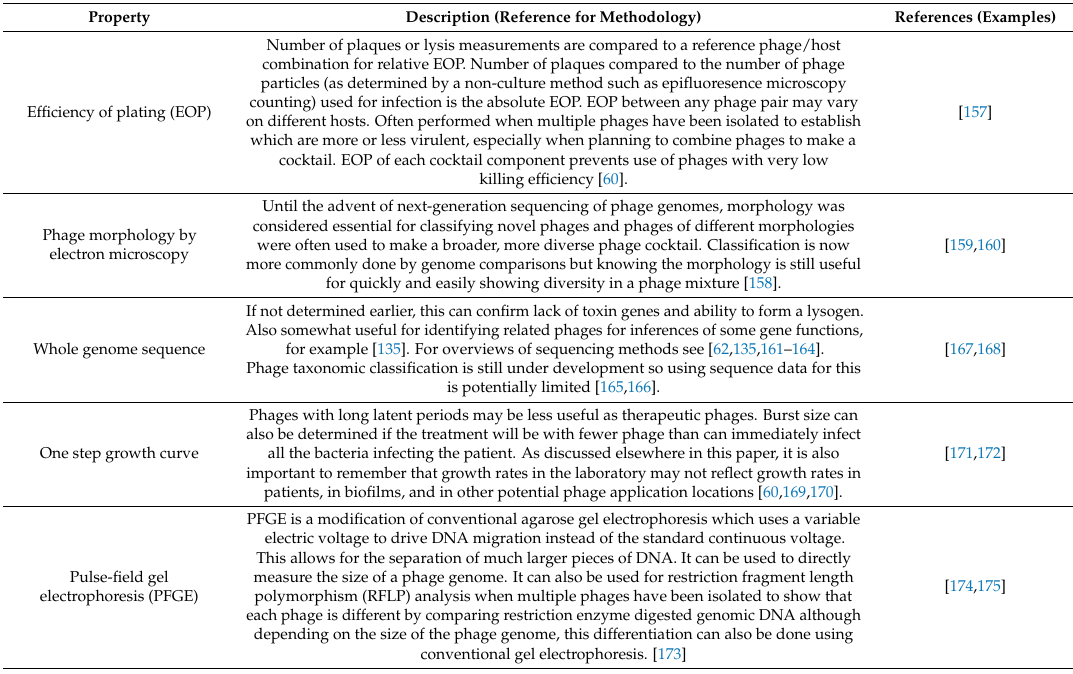
Table 2. Properties that are often tested in characterizing phages but are not essential for phage therapy.